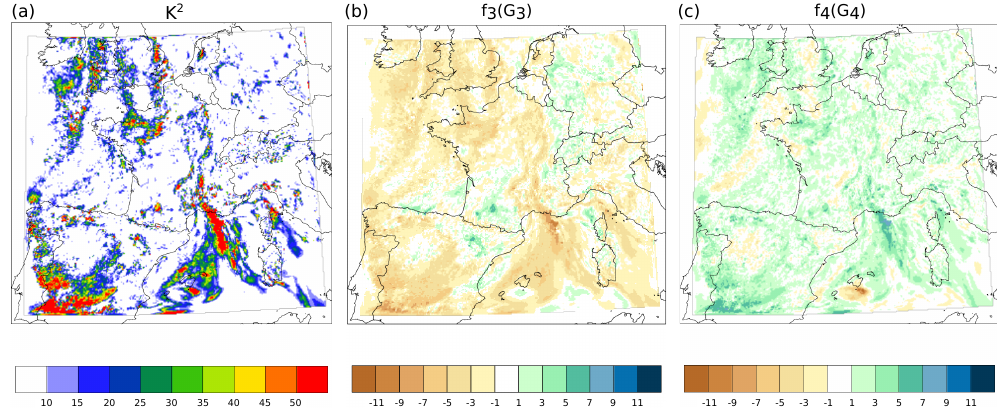
Figure 4. (a) K 2 , (b) transformed skewness f 3 (G 3 ) , and (c) transformed kurtosis f 4 (G 4 ) for q at model level 52 ( ≈ 920hPa), computed from the 90-member ensemble of AROME-France 3h-forecast valid at 03:00UTC on 4 November